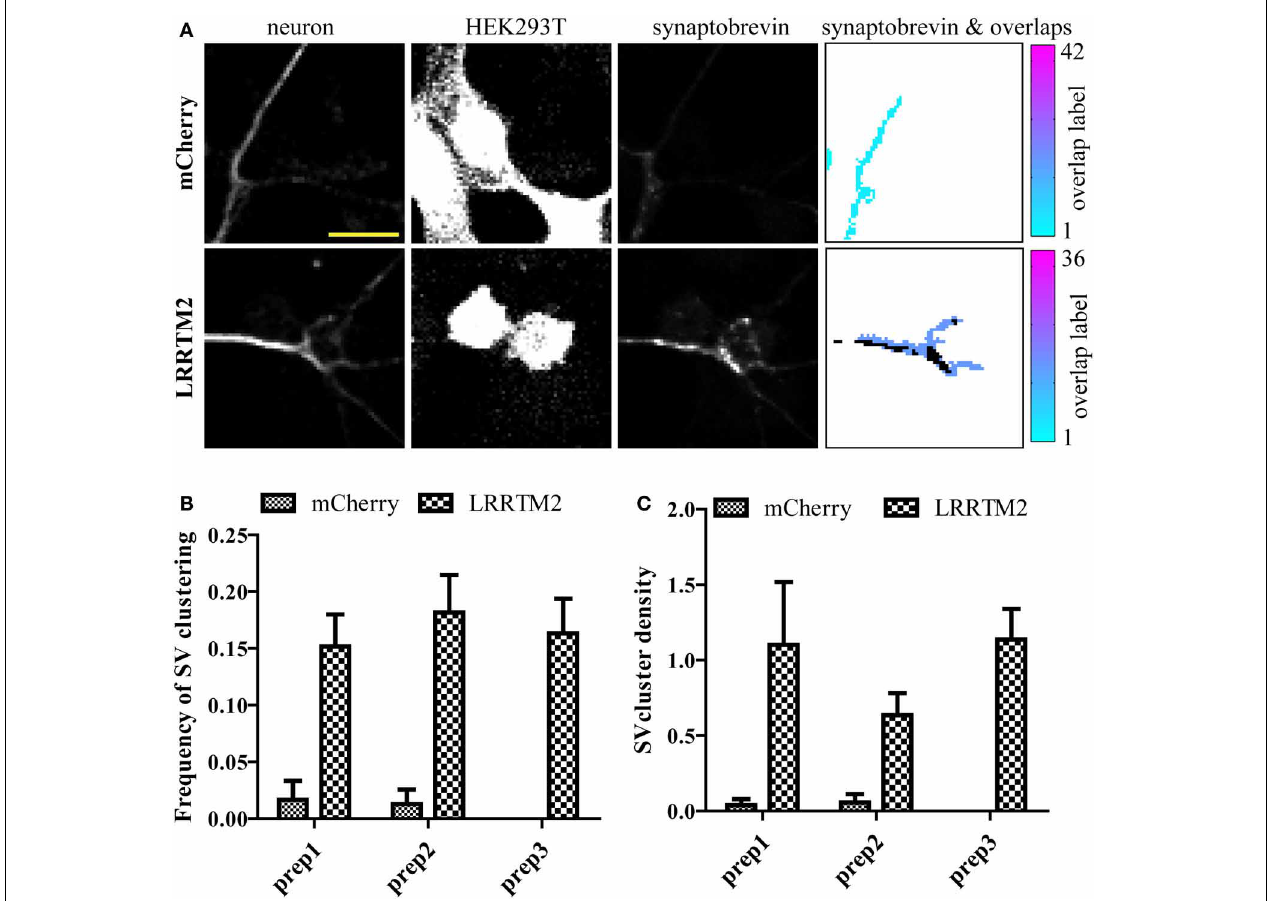
FIGURE 3 | Evaluating the variability of presynaptic induction using software-based analysis of synaptic vesicle (SV) clusters induced by LRRTM2. (A) Raw confocal images (20 × ) of GFP-expressing neurons cultured with HEK293T cells transfected with mCherry alone (top row) or mCherry and LRRTM2 (bottom row) and immunostained against synaptobrevin. The overlap region map and corresponding SV clusters (black) is displayed on the right. Scale bar, 20 µ m. (B) Mean percentage of